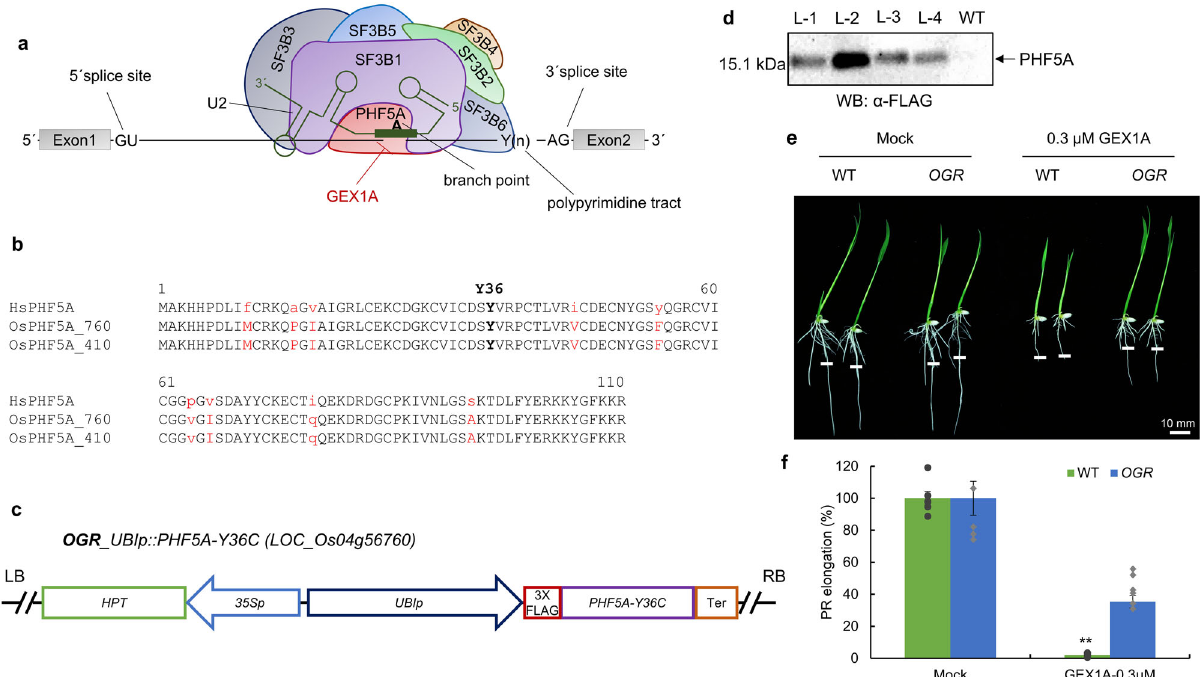
Fig. 3 Generation of PHF5A-Y36C heterologous expression in rice. a The structure of SF3B complex binding to U2 and the pre-mRNA intron. The branch point is in contact with SF3B1 and PHF5A. The branch point recognition sequence (BPRS) of U2 snRNA binds to branch point and fl anking nucleotides. b GEX1A interrupts these interactions and inhibit this early spliceosome assembly. The human PHF5A protein sequence is aligned with sequences of rice PHF5A homologs. PHF5A-Y36C (highlighted in bold) confers tolerance to splicing modulators (Teng et al., 2017) and is highly conserved among eukaryotes. c The coding sequence of rice OsPHF5A ( LOC_Os4g56760 ) was mutated (Y36C; TAT to TGT) and cloned into a construct under the control of the Ubiquitin promoter with a 3XFLAG-tag. d Con fi rmation of PHF5A-Y36C heterologous expression in transgenic lines. Total protein was extracted from independent lines of O. sativa cv japonica transformed with UBIp::PHF5A-Y36C. Anti-FLAG antibody was used to detect FLAG-tagged PHF5A-Y36C. The arrow indicates the presence of PHF5A. WT was used as a negative control. e , f Heterologous expression of PHF5A-Y36C confers tolerance to GEX1A. Rice seeds were germinated on 1 ⁄ 2 MS media for 3 days, then transferred onto 1 ⁄ 2 MS media supplemented with 0.3 μ M GEX1A for 3 days. Root tips were marked to observe post-transfer growth. The transgenic lines were termed OGR (Overexpression-PHF5A GEX1A